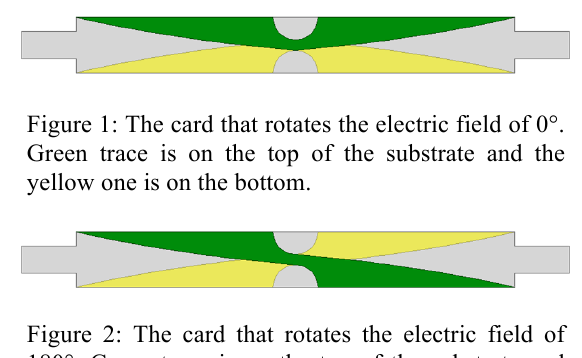
rotates the electric field in the clockwise for 180°, obtaining the desired phase shifting between the two cards.